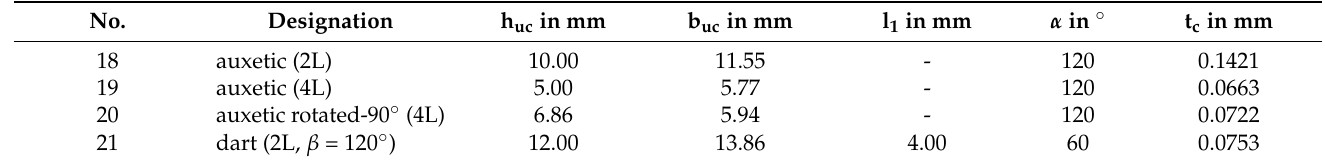
Table 3. Topology and parameters: one-side-open auxetic prismatic cell cores. See Figure